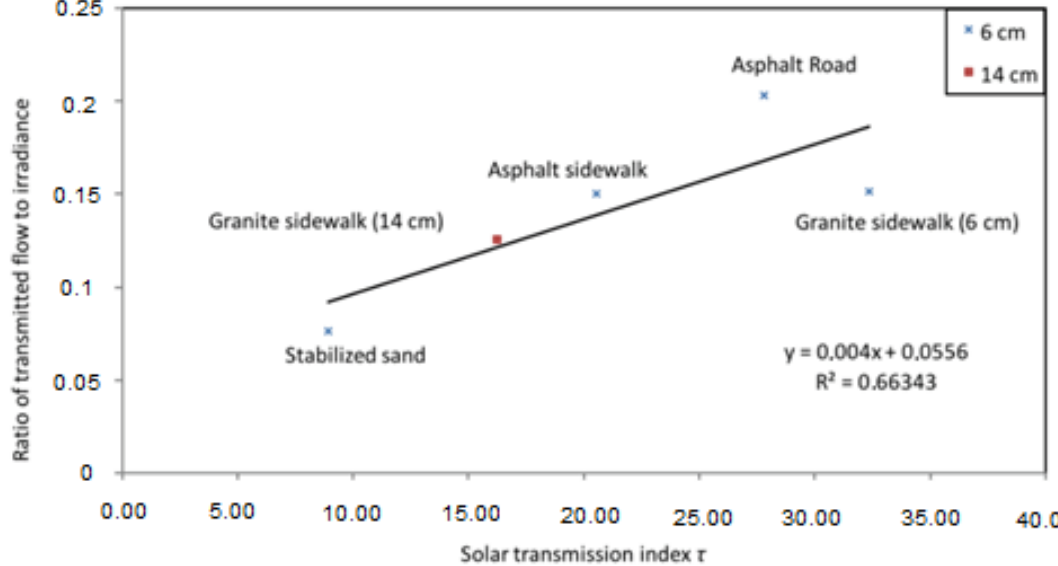
Figure 8. The ratio of heat flow to irradiance as a function of solar transmission index (Modified after Hendel et al.)